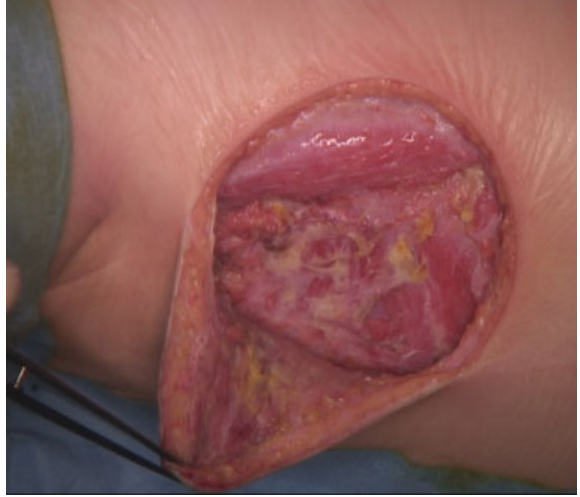
Fig. 4 Clinical presentation after 2